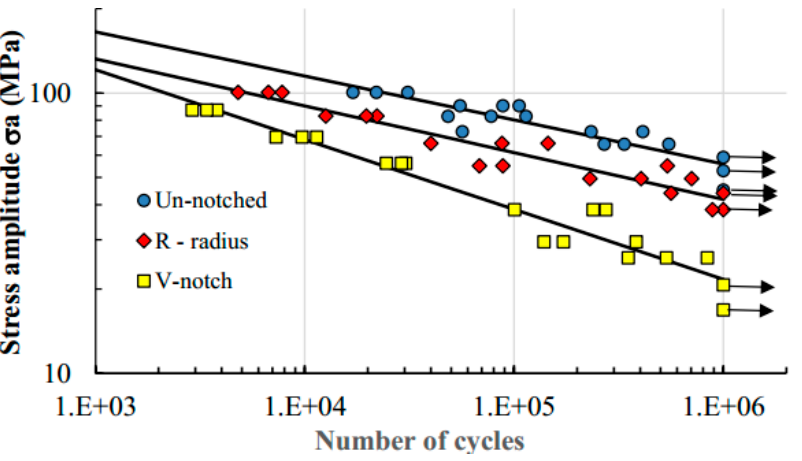
Figure 5. Comparison of S-N curve as HCF behavior of AM50 magnesium alloy considering different notch shapes “Reused with permission from Elsevier by License No. 5494611488014” [23].